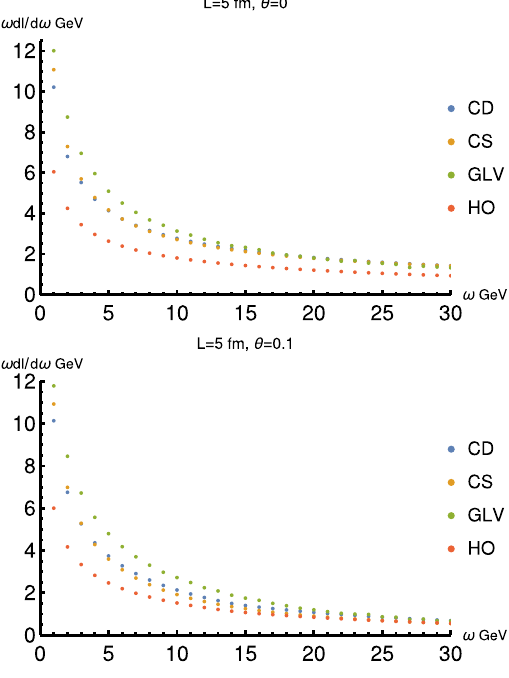
energy losses for typical momenta Q given by Eqs. 19, 20 respec- tively.HO refers to HO approximation with Q given by Eq. 56, and GLV refers to N = 1 GLV expression with Q independent ˆ q